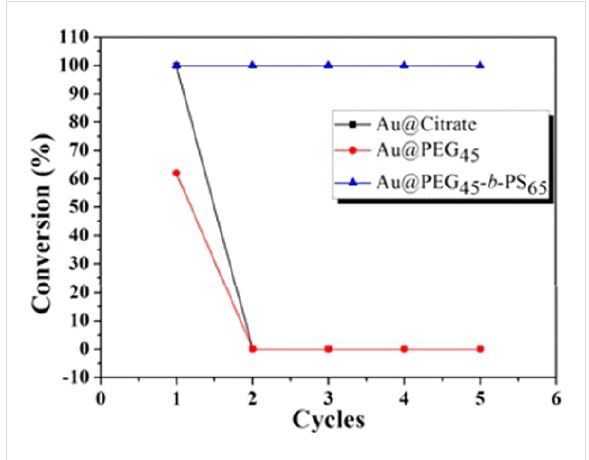
Figure 8: Conversion of 4-NP in five successive cycles of reduction, catalyzed by Au@citrate, Au@PEG and Au@PEG 45 - b -PS 65 . Reprinted with permission from [121]. Copyright 2015 American Chem- ical